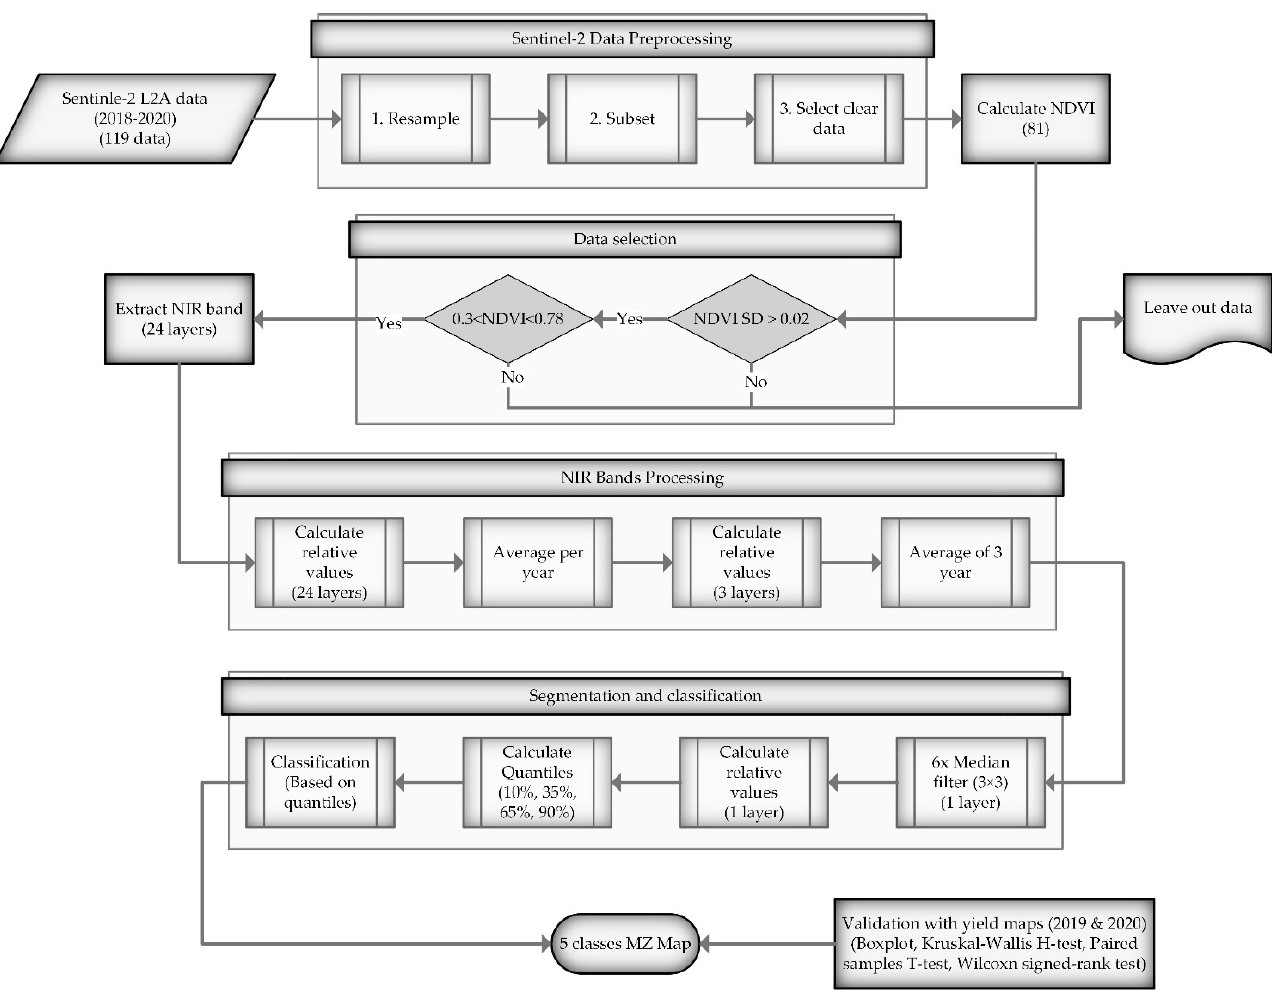
Figure 2. The workflow of model-1 (RS- and threshold-based